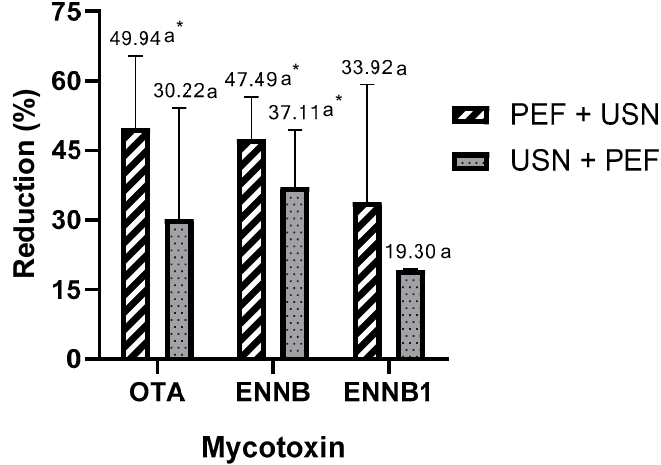
Figure 2. Reduction percentage (%) of Ochratoxin A, Enniatin B, and Enniatin B1 in orange juice with milk after PEF + USN treatment vs. after USN + PEF treatment. (ab, for each mycotoxin different letters indicate different percent reduction rates between treatments) (* indicates a significant reduction concerning the control). OTA: Ochratoxin A, ENNB: Enniatin B, ENNB1: Enniatin B1, USN: Ultrasounds, PEF: Pulsed Electric Fields. Table 3. Contents of Ochratoxin A, Enniatin B, and Enniatin B1 in orange juice with milk after the combination of treatments selected.